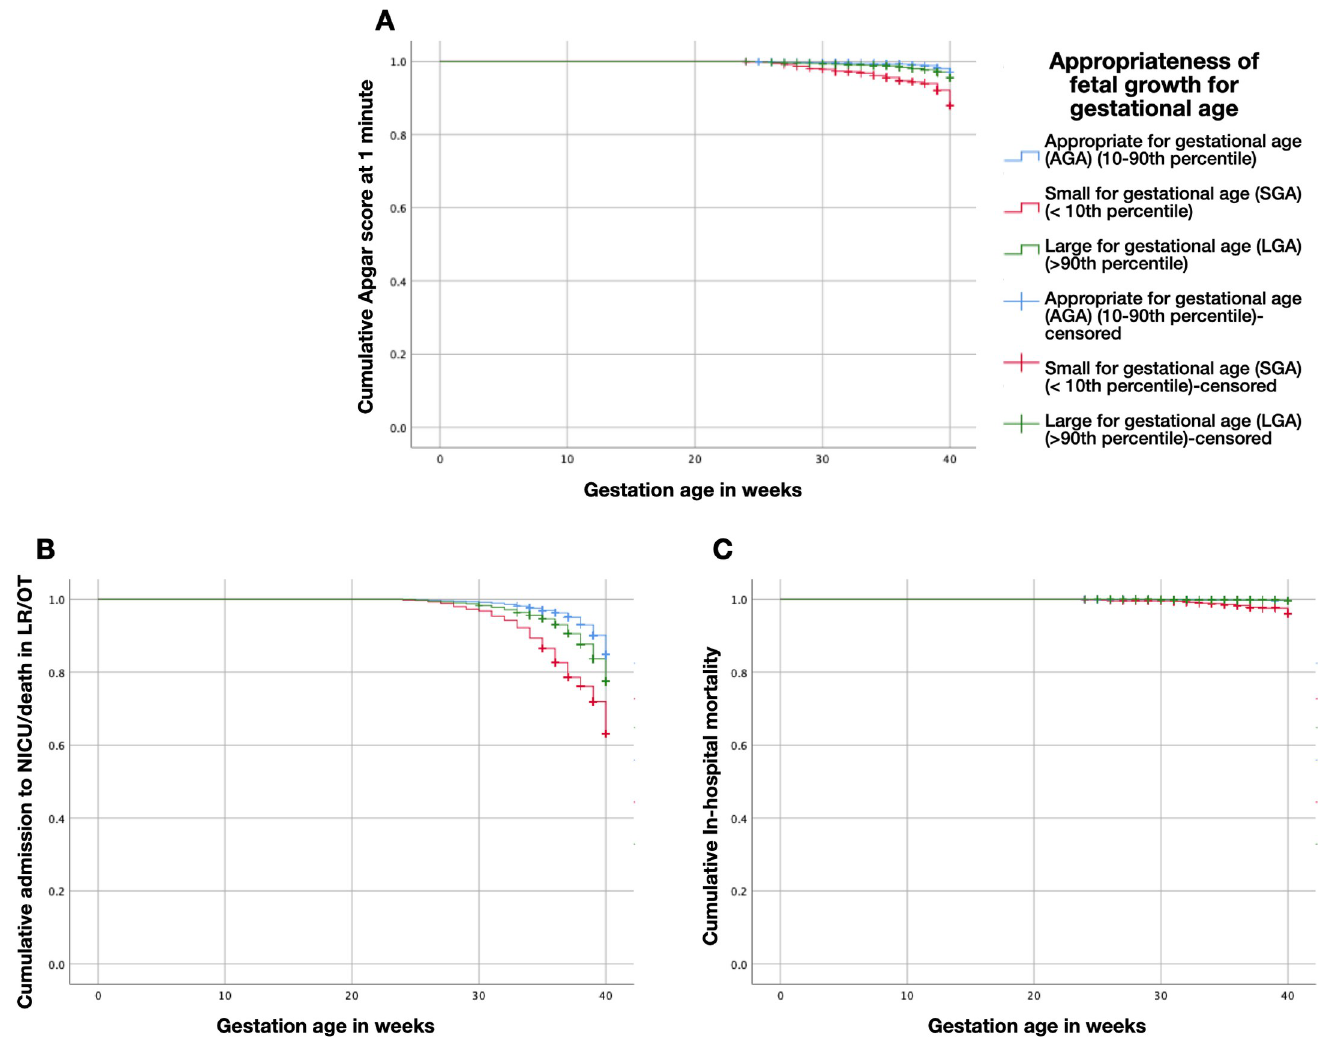
Fig 1. Kaplan-Meier curves assessing differences in medians, among the three groups (AGA, SGA and LGA) for the outcomes during the course of 24–40 weeks of gestation. ( A ) Apgar score, ( B ) NICU/death in LR/OT, and ( C ) in-hospital